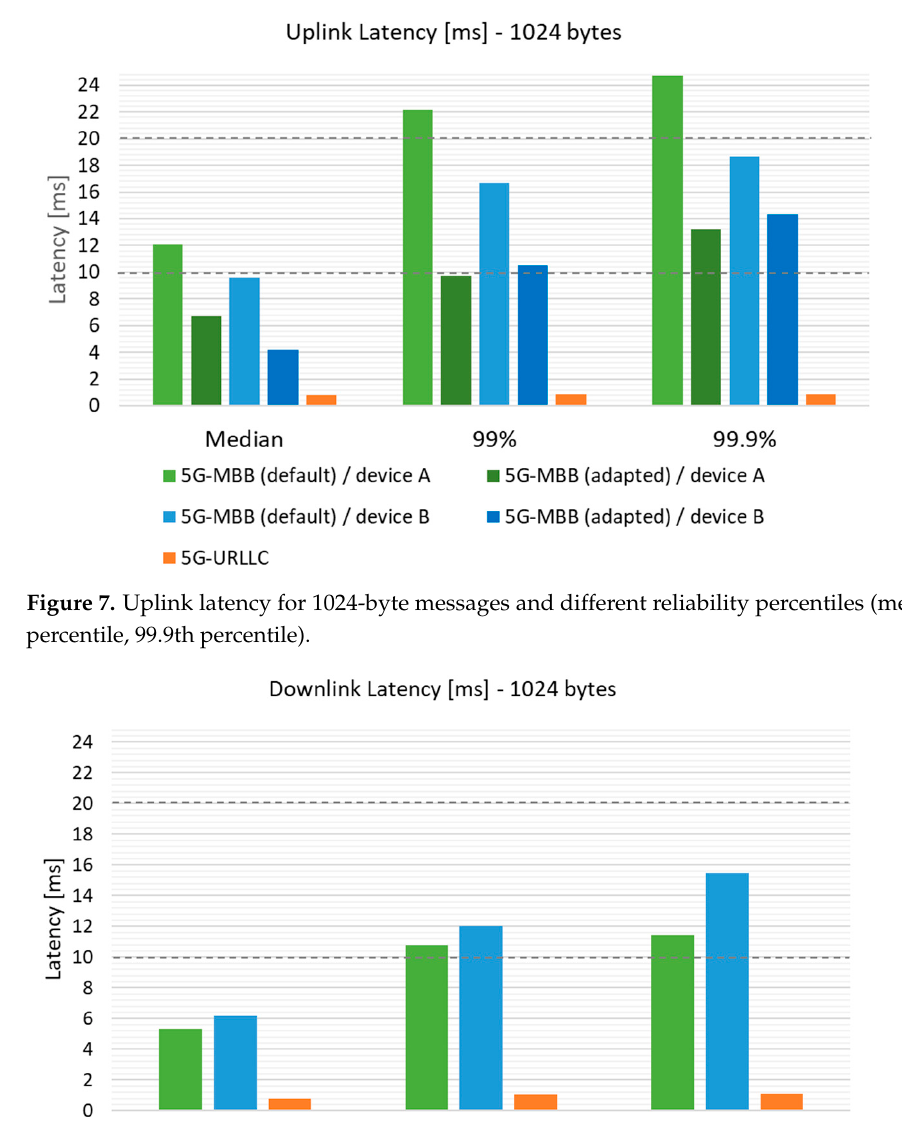
Figure 6. Downlink latency for 100-byte messages and different reliability percentiles (median, 99th percentile, 99.9th percentile).